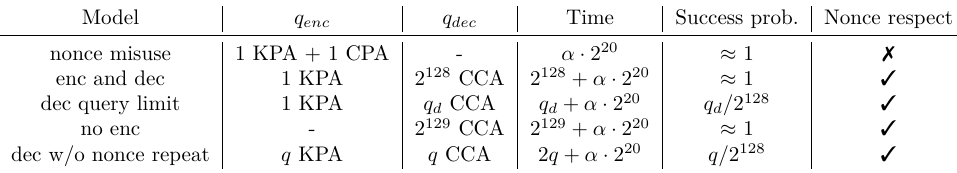
Table 2: Summary of attacks under various security models. q enc denotes the type and the number of encryption queries, where KPA denotes a known-plaintext query and CPA denotes a chosen-plaintext query. q denotes the type and the number of decryption dec queries. α denotes a small constant when the attack complexity increases